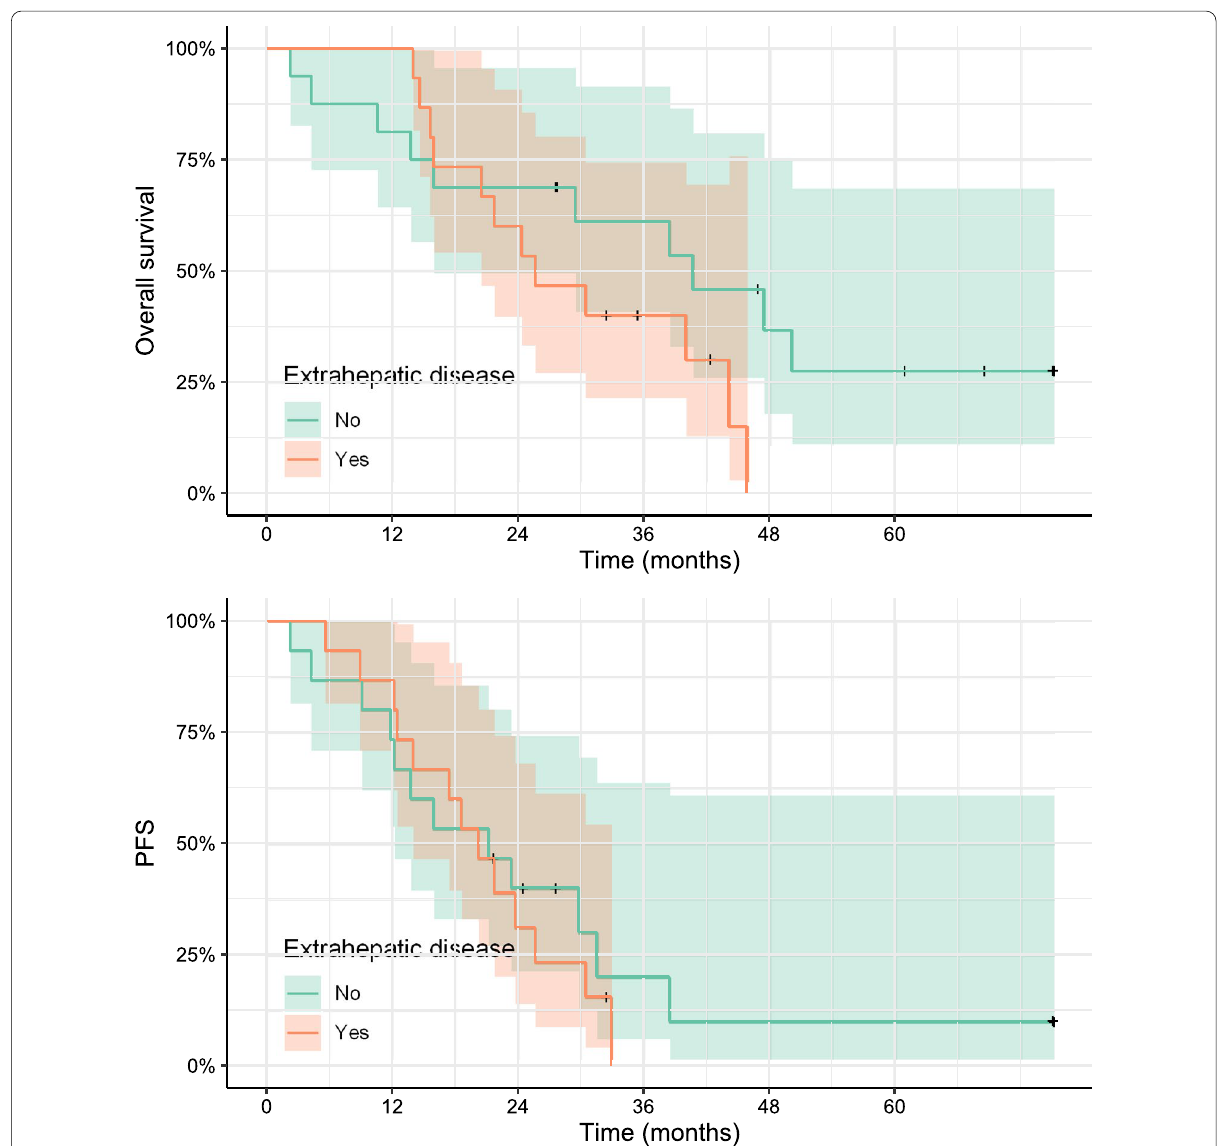
Fig. 6 Difference in overall survival and progression-free survival in patients with or without extrahepatic disease (excluding lymph node